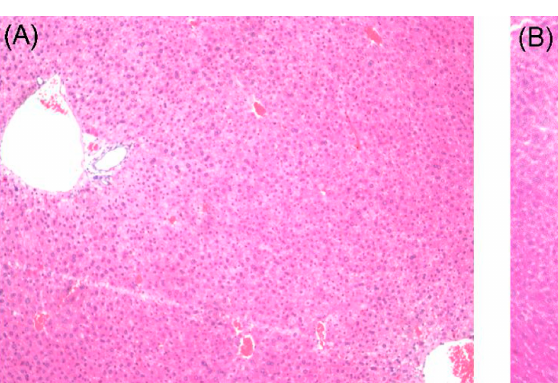
Figure 2. Histological examination of rat livers stained with H&E. ( A ) Normal group, without any abnormal morphological alternations; ( B ) Model group, showing marked morphological disruption; ( C ) CUR-L group, showing moderate regression of morphological changes; ( D ) CUR-H group, showing marked regression with a large amount of alleviation in the abnormal area. Original magnification